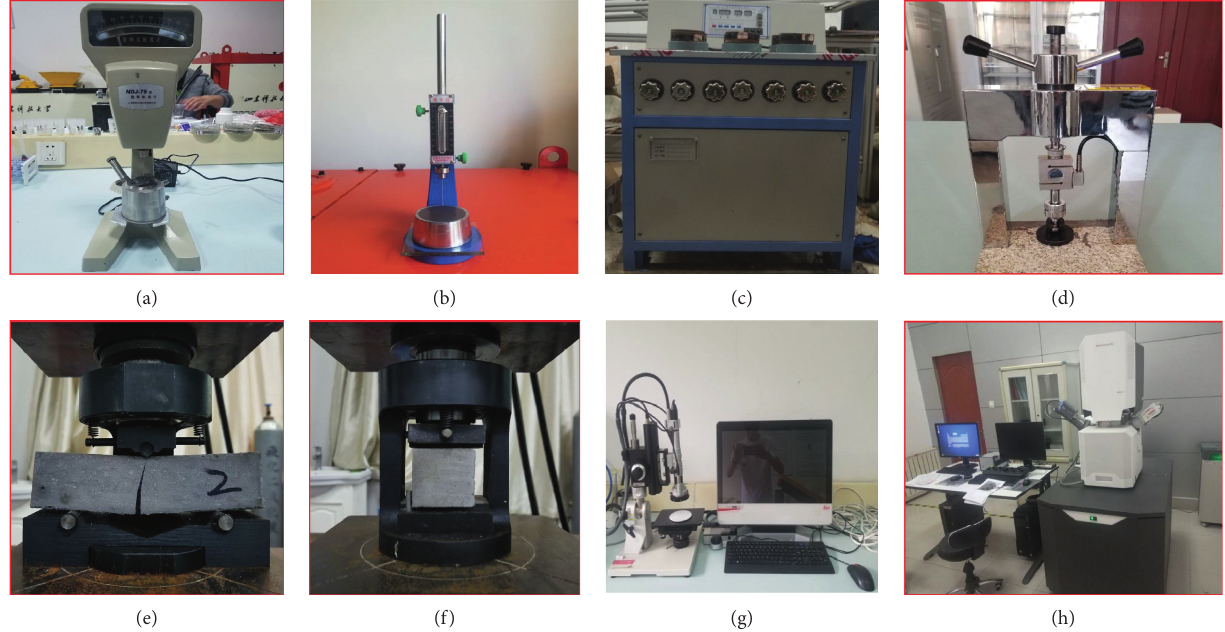
Figure 4: Experimental test process. (a) Viscosity test. (b) Setting time test. (c) Permeability test. (d) Bond test. (e) Three-point bending test. (f) Compressive strength test. (g) Microscopic observation. (h) SEM